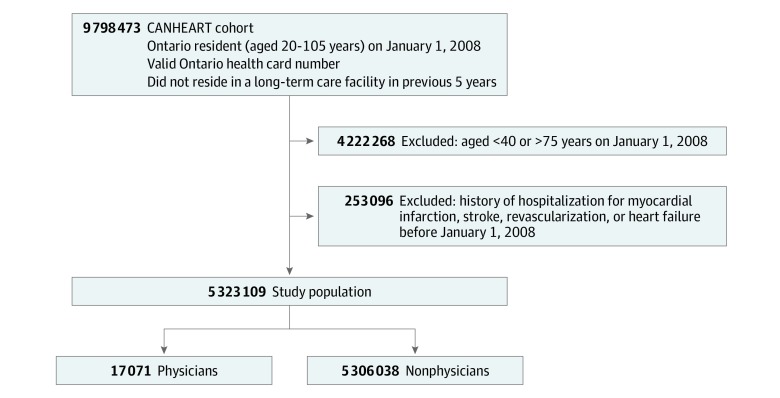
Cohort CreationFlowchart shows exclusion criteria for the Cardiovascular Health in Ambulatory Care Health Research Team (CANHEART) cohort.